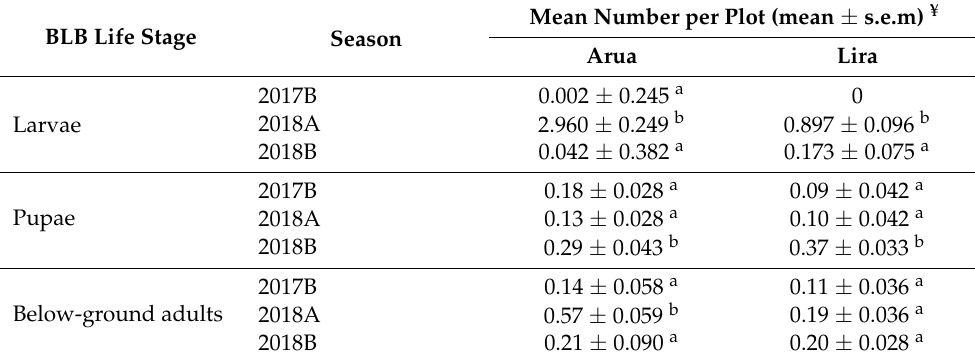
Table 3. Mean number of larvae, pupae, and teneral adults of Ootheca spp. recovered in the soil during 2017B, 2018A, and 2018B seasons in Arua and Lira districts, 2017A to 2018B. Mean Number per Plot (mean ± s.e.m) ¥ BLB Life Stage Season Arua Lira 2017B 0.002 ± 0.245 a 0 2018A 2.960 ± 0.249 b 0.897 ± 0.096 b Larvae 2018B 0.042 ± 0.382 a 0.173 ± 0.075 a 2017B 0.18 ± 0.028 a 0.09 ± 0.042 a Pupae 2018A 0.13 ± 0.028 a 0.10 ± 0.042 a 2018B 0.29 ± 0.043 b 0.37 ± 0.033 b 2017B 0.14 ± 0.058 a 0.11 ± 0.036 a Below-ground adults 2018A 0.57 ± 0.059 b 0.19 ± 0.036 a 2018B 0.20 ± 0.028